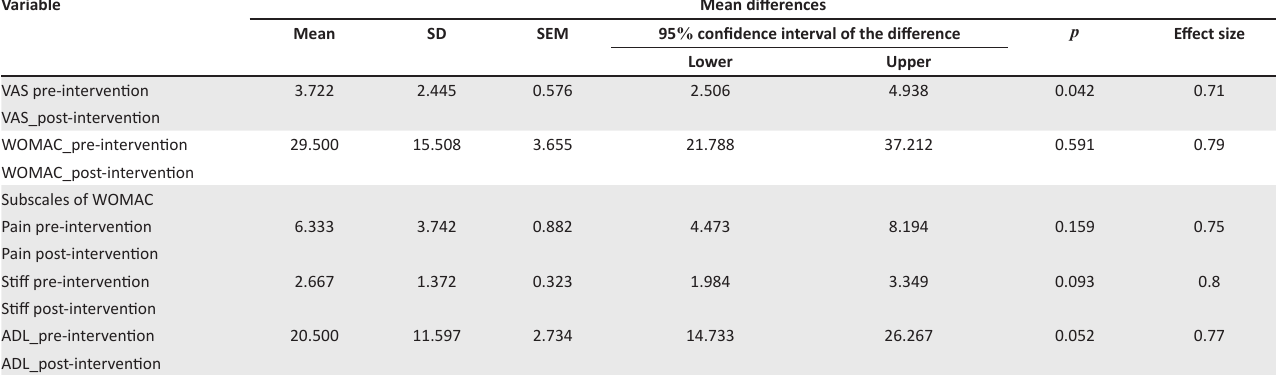
TABLE 3: Mean differences of the pre- and post-test in Visual Analogue Scale and Western Ontario and McMaster Universities Osteoarthritis Index scores. Variable Mean